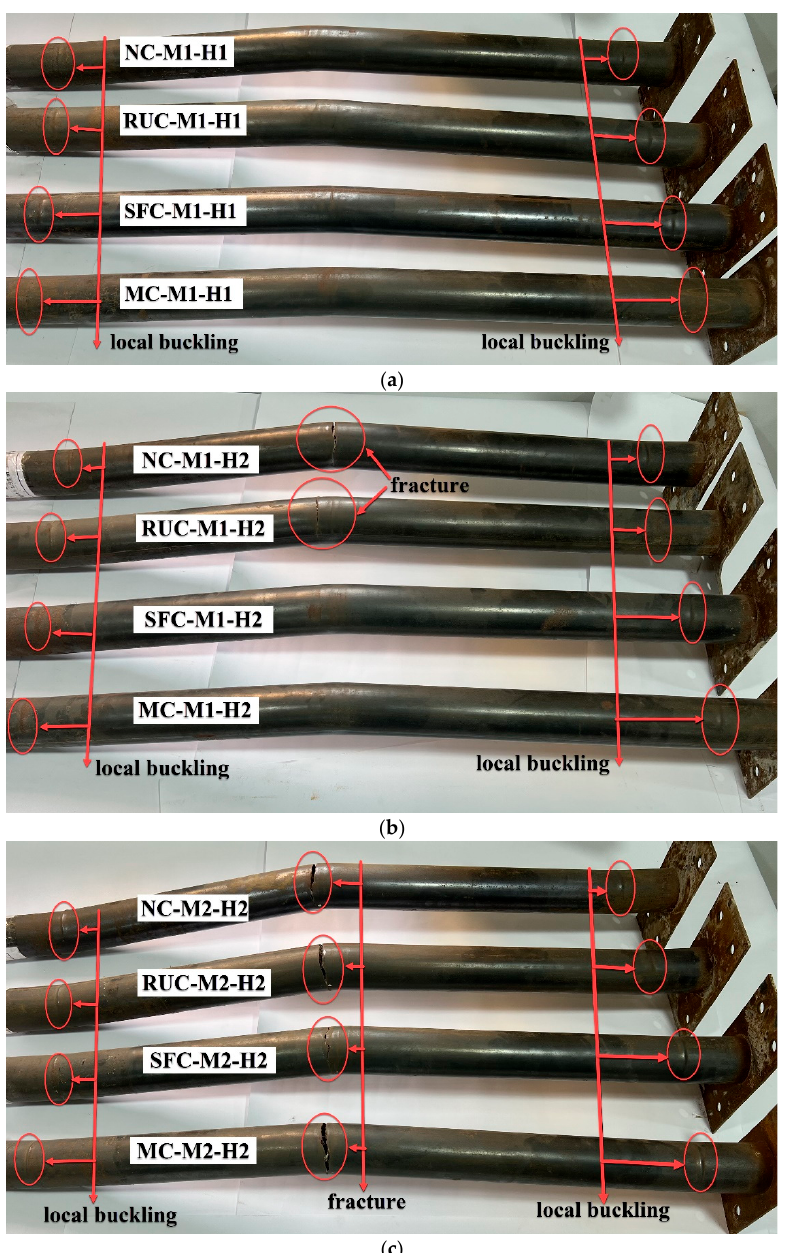
Figure 4. Tested specimens:( a ) group I (M1-H1); ( b ) group II (M1-H2); ( c ) group III (M2-H2). Under lateral impact loading, the response of the CFST specimens wasdominated by a mix of local bucklingand global flexural deformation. The modes of failure of the specimens indicate the interaction effect between the inner concrete and the outer steel tube. Due to the inner concrete’s support, less local buckling was observed in the com- pression zone at the top of the mid-span section and the bottom of the fixed and slid-